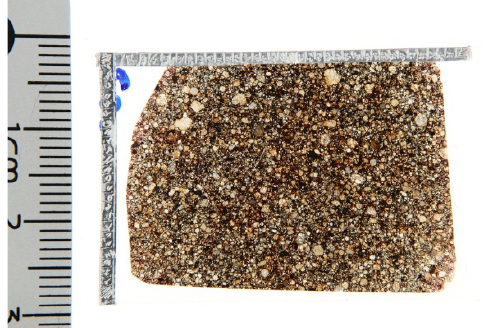
Figure 1. Image of the meteorite thin section used as study-case sample for the present study, in back-diffused light. Several chondrules structures are clearly visible at naked eye. The fixed coordination system made by Al-tape stuck on the supporting glass side is also visible.